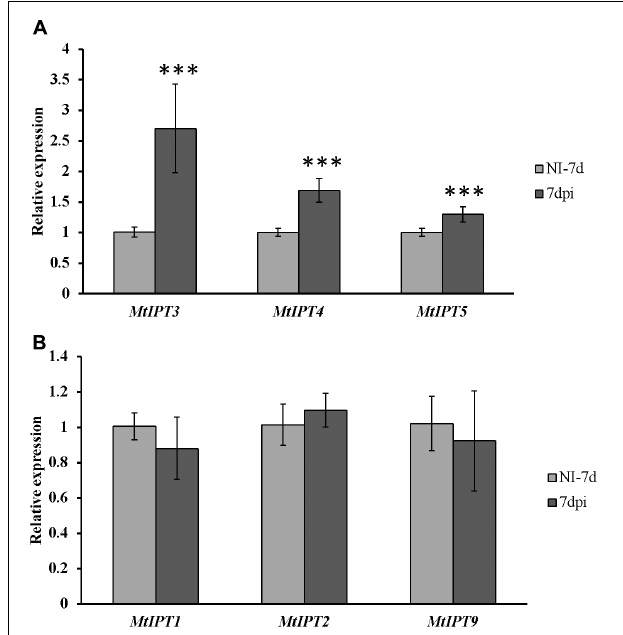
FIGURE 5 | Relative expression of MtIPT1-5 and MtIPT9 in the first leaf of A17 plants at 7 dpi. The expression levels of MtIPT3 , MtIPT4, and MtIPT5 are increased (A) , while the expression levels of MtIPT1 , MtIPT2, and MtIPT9 do not changed significantly (B) in comparison with non-inoculated plants (NI). Asterisks indicate statistically significant differences compared with control (NI): ∗∗∗ P < 0.001, ∗∗ P < 0.01, ∗ P < 0.05. Error bars indicate the 95% confidence interval of three biological repeats.